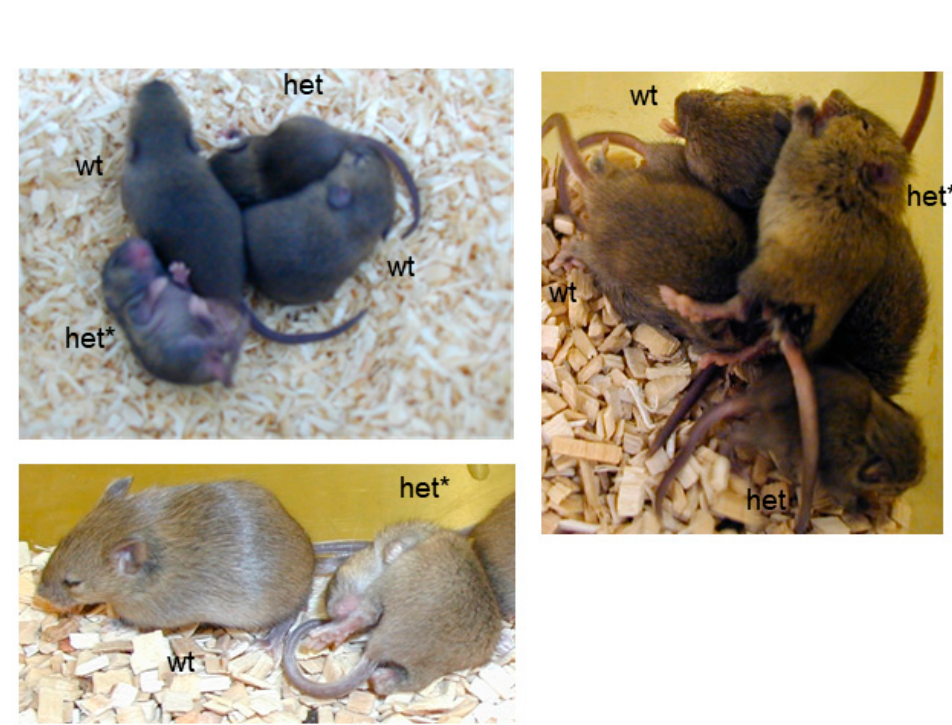
Figure 1. Growth deficit and abnormal behavioural phenotype of mutant line Trpc7 K810Stop . ( A ) Development of body weight (mean ± standard deviation) in heterozygous mutant male (black) and female (grey) mice and C3H littermate controls (dashed lines) during the first three weeks post partum. n = 11–34 per sex and genotype. Significance vs. wild-type controls: b, p < 0.01 (day 8 p.p. only for females); c, p < 0.001. Reduced body weight as well as reduced nose-rump length of a female heterozygous mutant mouse (het) at the age of 15 days post partum compared to a female wild-type (wt) C3H littermate ( right panel, top ). The analogous phenotype of the mutation is observed in the C57BL/6 genetic background ( right panel, bottom ). ( B ) Representative images showing heterozygous mutant mice (het) at the age of 10–20 days post partum compared to wild-type C3H littermates (wt). The heterozygous mutants depicted with a star (het*) underwent seizure-like attacks involving both the body and the limbs during the image taking. In addition, an increased frequency of a probably irritation-induced self-grooming and scratching behaviour of body and limbs was